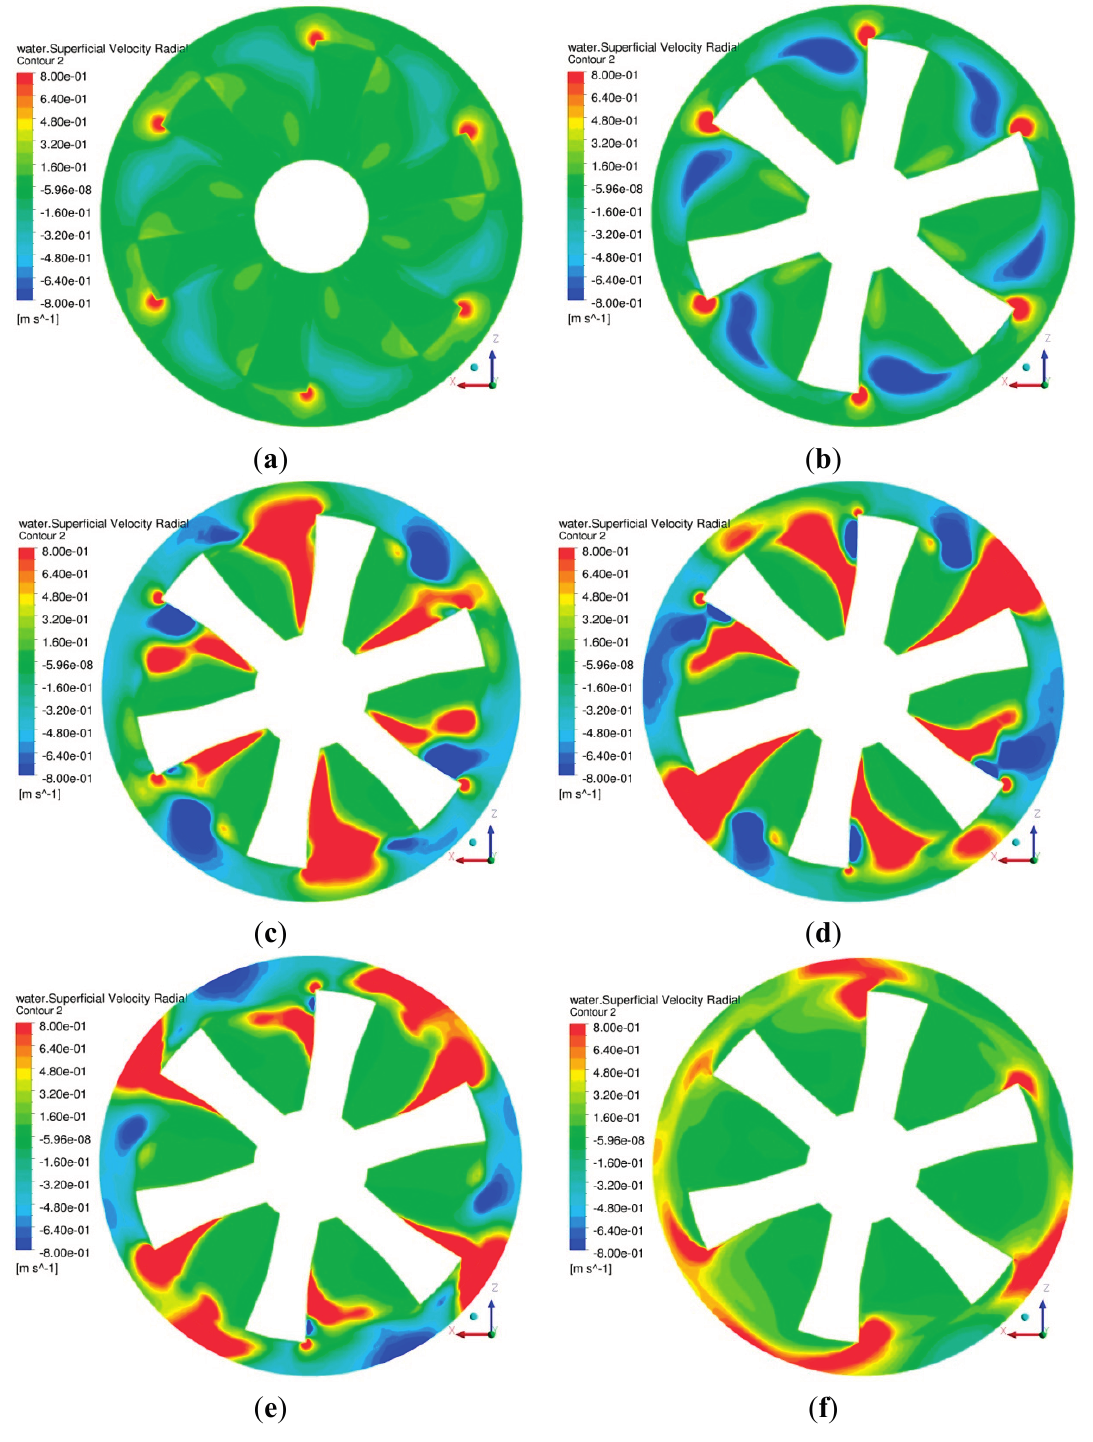
Figure 6. Water superficial radial velocity contours in horizontal planes cutting rotor blades, t = 14.35 s, d b = 0.7 mm; ( a ) y = 0.86 m; ( b ) y = 0.87 m; ( c ) y = 0.9 m; ( d ) y = 0.92 m; ( e ) y = 0.96 m; ( f ) y = 1.10